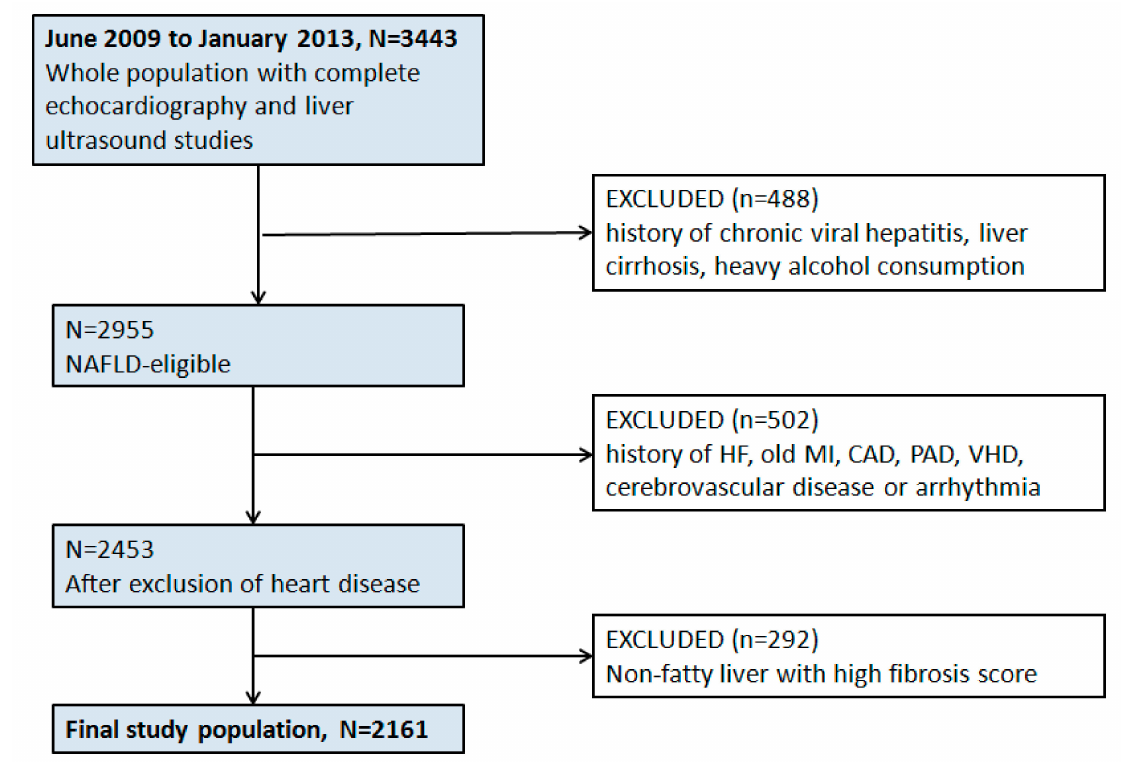
Figure 1. Study design and exclusion flowchart. Abbreviations: HF = heart failure, MI = myocar- dial infarction, CAD = coronary artery disease, PAD = peripheral artery disease, VHD = valvular heart